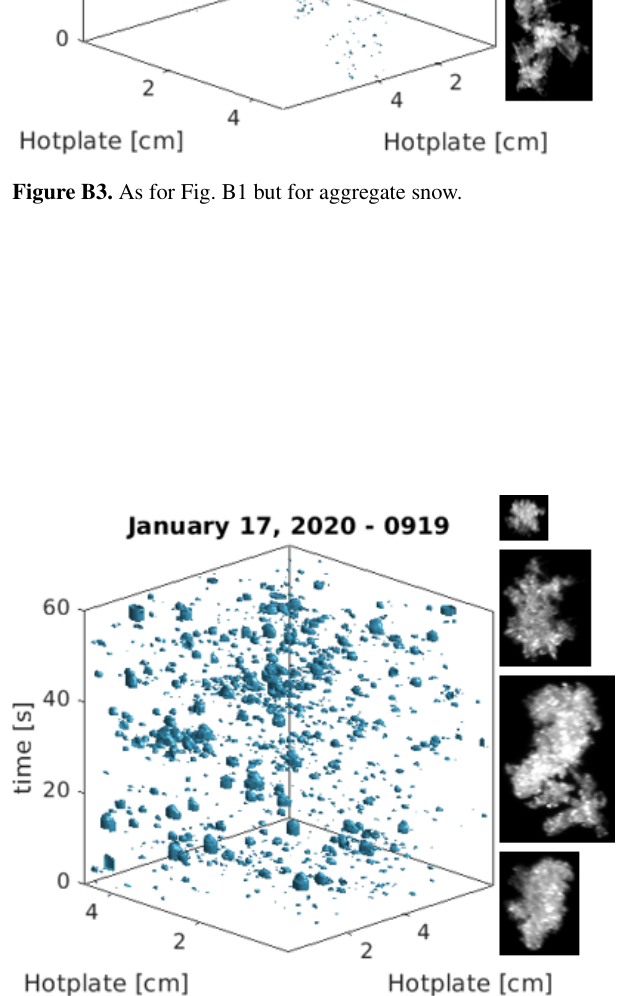
Figure B4. As for Fig. B1 but for densely rimed aggregate snow.